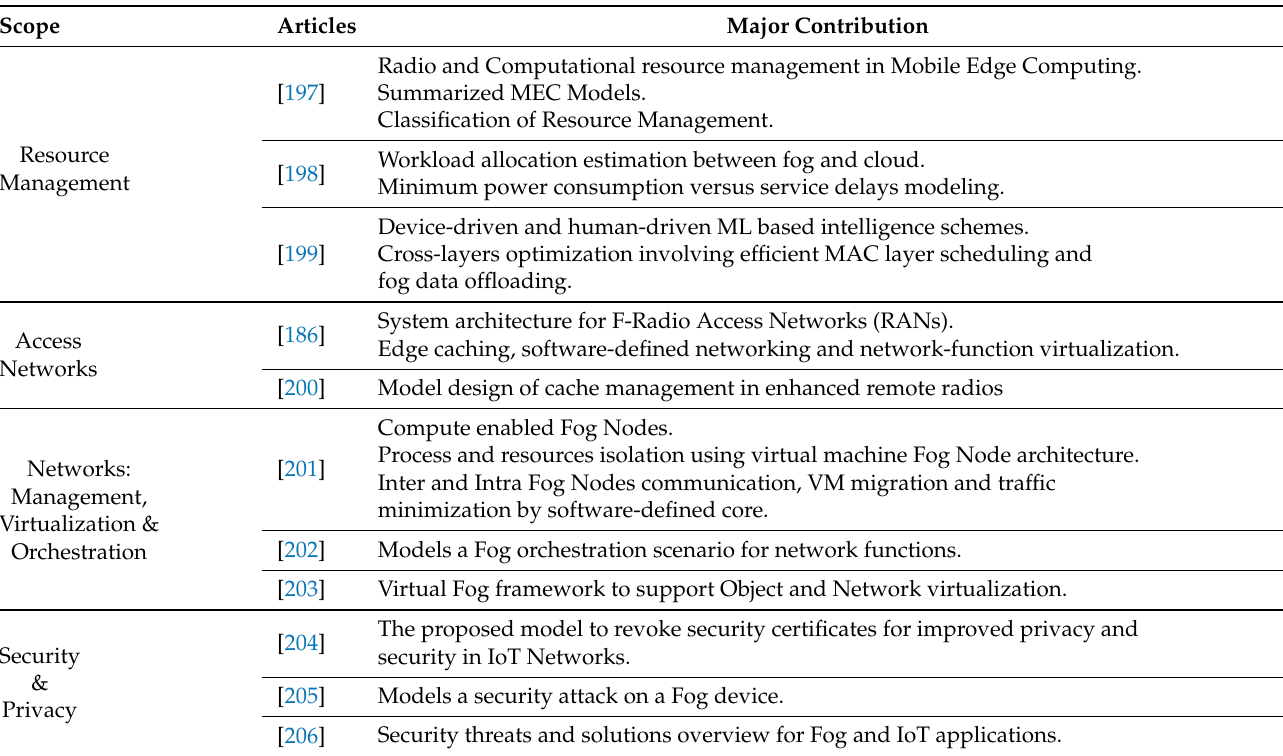
Table 12. State-of-the-art research on mitigating security concerns of Edge